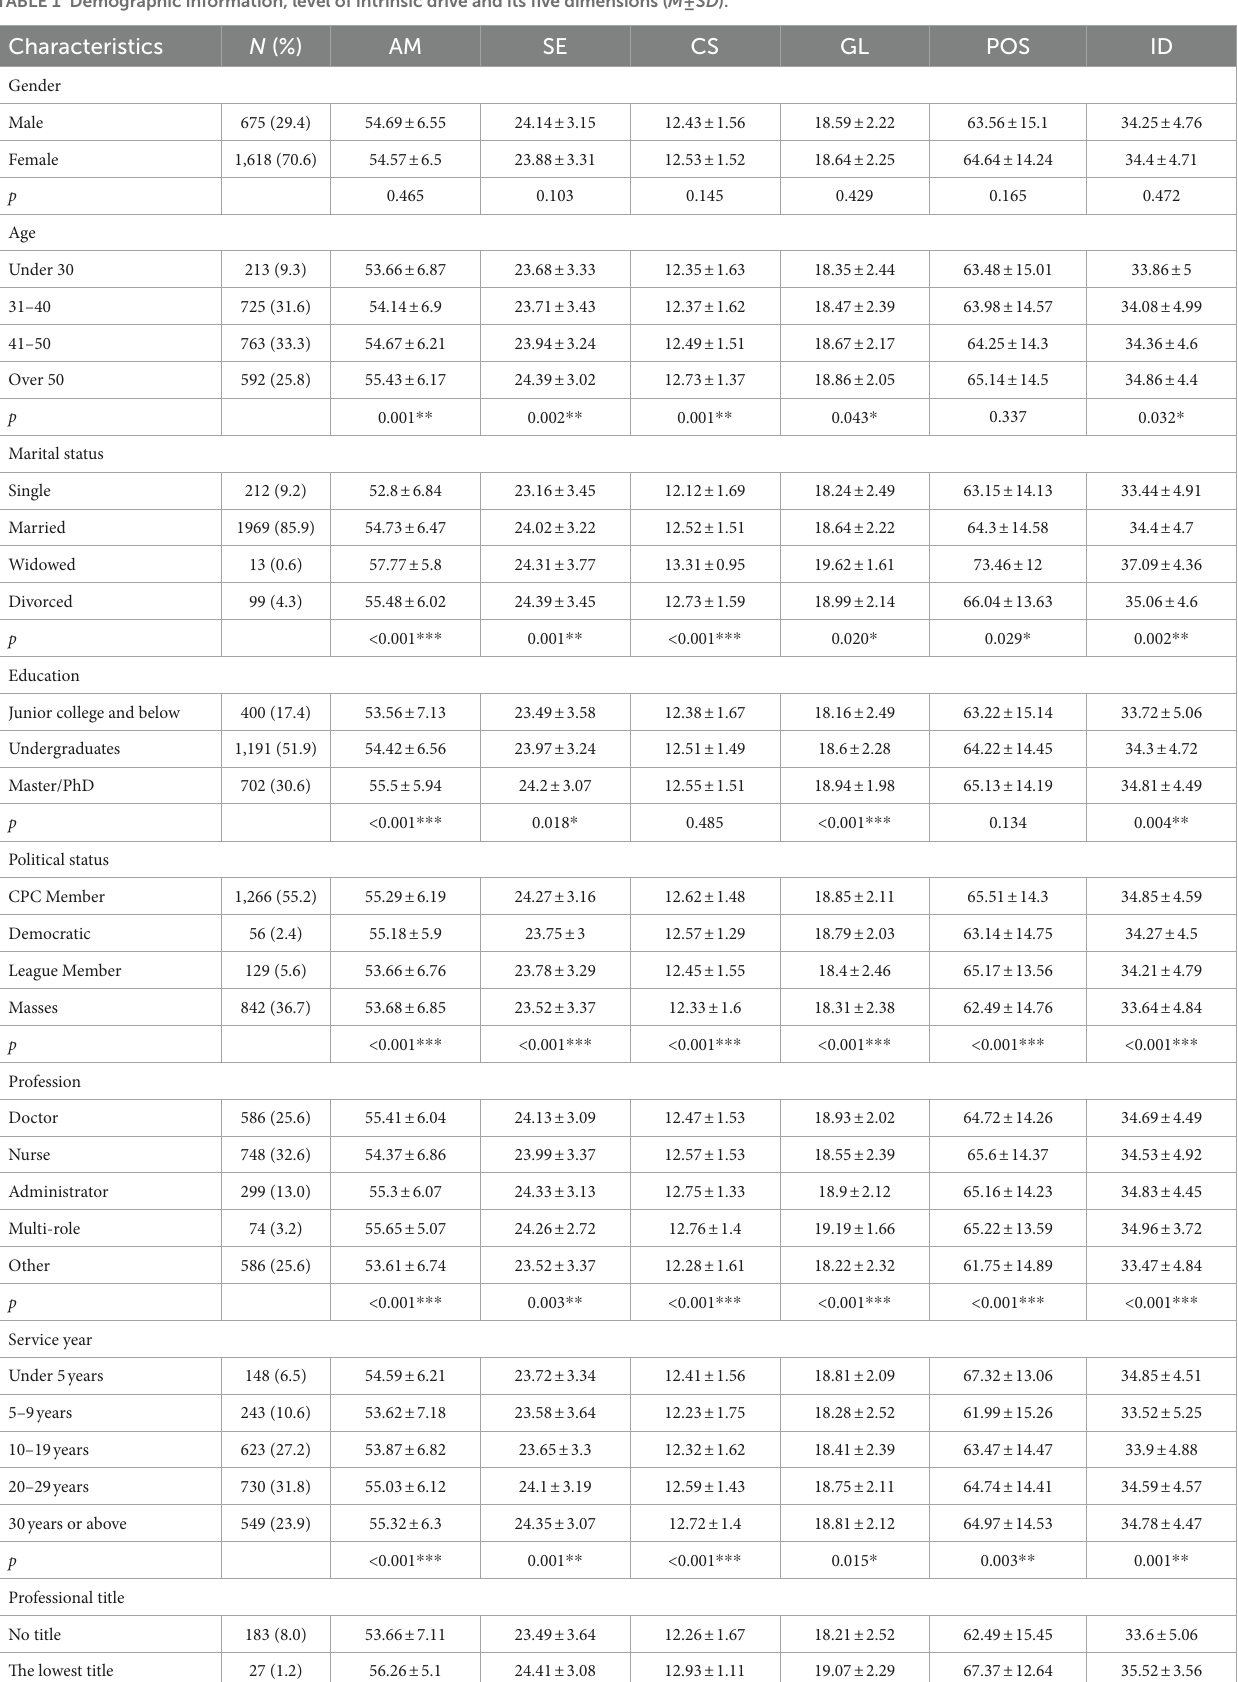
TABLE 1 Demographic information, level of intrinsic drive and its five dimensions ( M ± SD ).